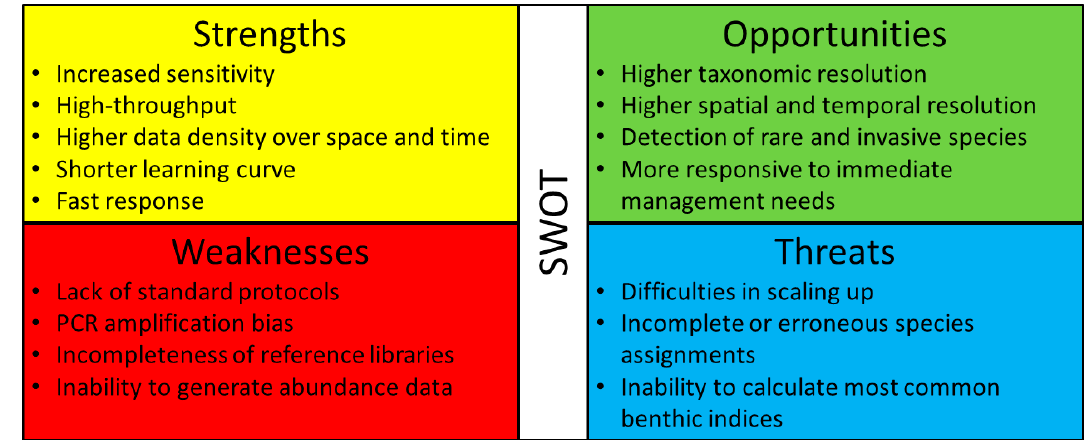
Figure 7. SWOT analysis of the application of DNA metabarcoding in aquatic ecosystems bioassessment using benthic macroinvertebrates.